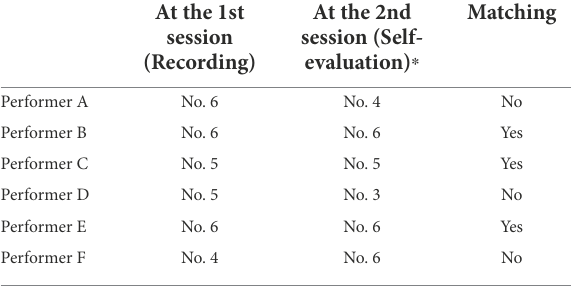
TABLE 3 Choice of the best